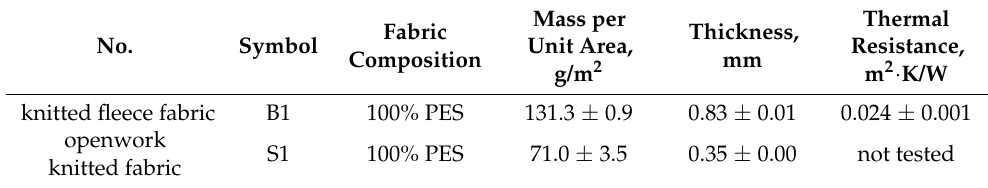
Table 1. Characteristics of the textile materials used for the preparation of heating inserts.